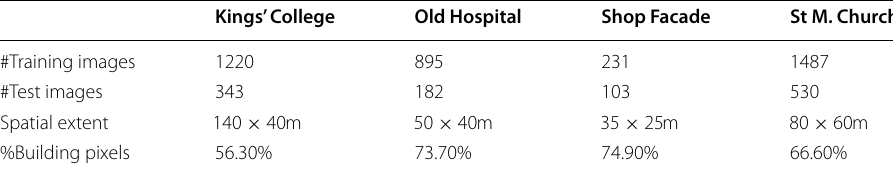
Table 1 Dataset statistics and percentage of building category pixels